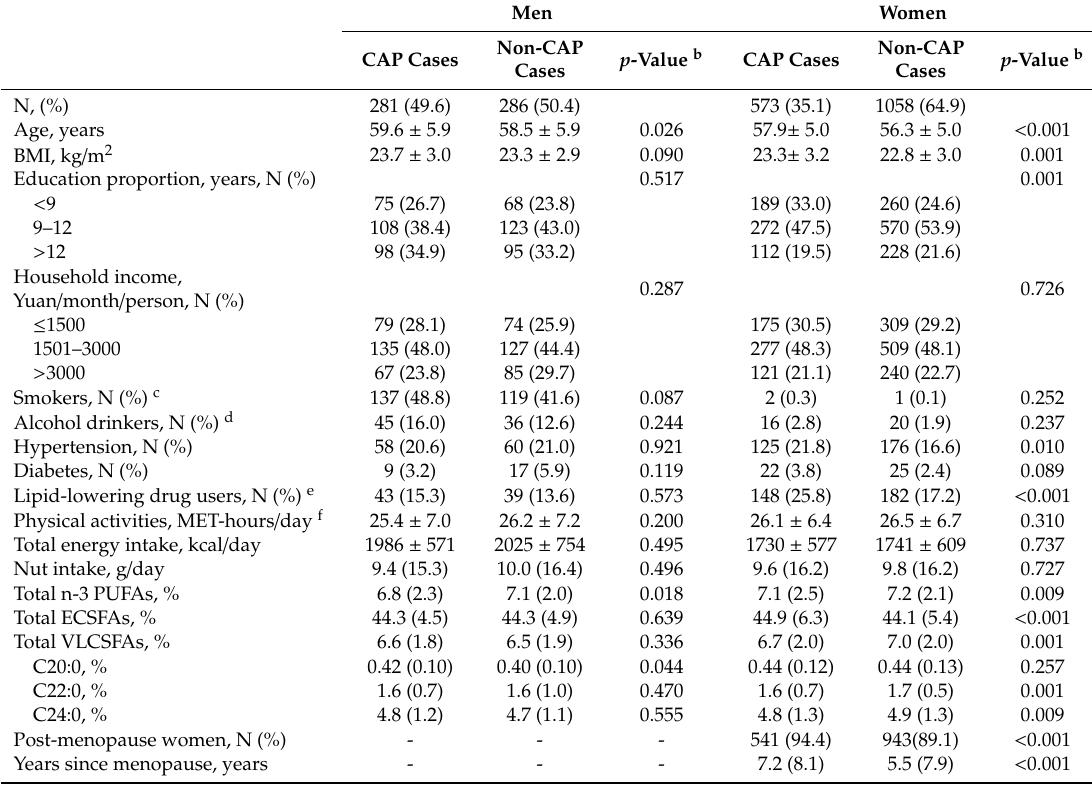
Table 1. Baseline characteristics of a cohort of 2198 Chinese adults with and without carotid artery plaque (CAP) stratified by sex a